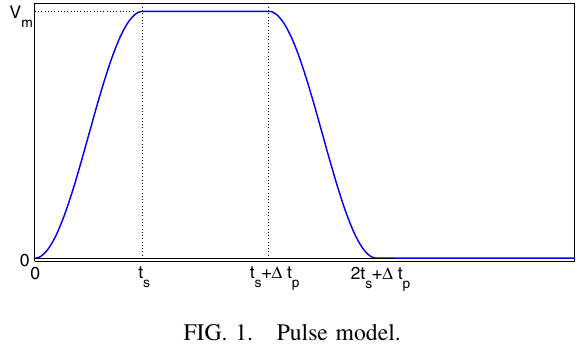
FIG. 1. Pulse model.